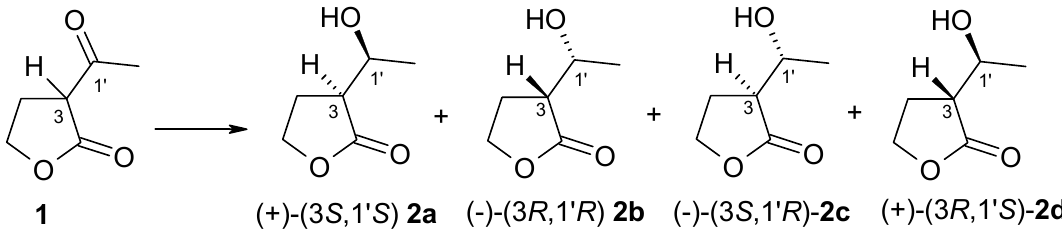
Figure 1. Structures of substrate 1 and stereoisomers of product 2 .